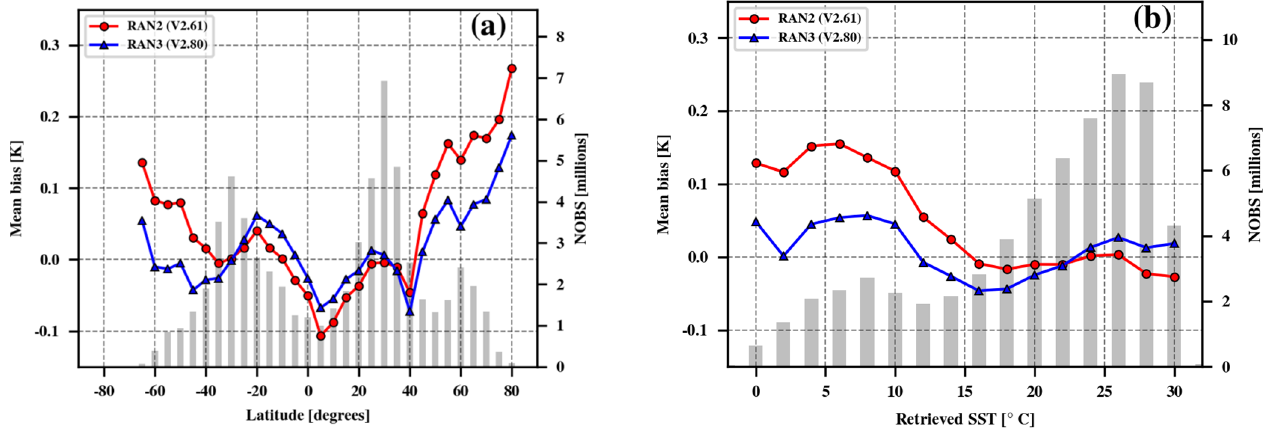
Figure 2. ACSPO NPP ‘subskin’-(D+TM) SST for the full year of 2020, stratified by ( a ) latitude and ( b ) retrieved ‘subskin’ SST in RAN2 (produced with ACSPO V2.61) and RAN3 (produced with ACSPO V2.80). The number of observations (NOBS) in the RAN3 datasets is denoted by gray histograms. Bins with NOBS < 5% of the median NOBS were omitted. Table 3. Coefficients of the HL correction term, ∆ HL , for NPP and N20 ‘subskin’ and ‘depth’ SSTs. The ACSPO SSTs are obtained by adding ∆ HL to the NLSSTs calculated by Equations (1) and (2). Satellite